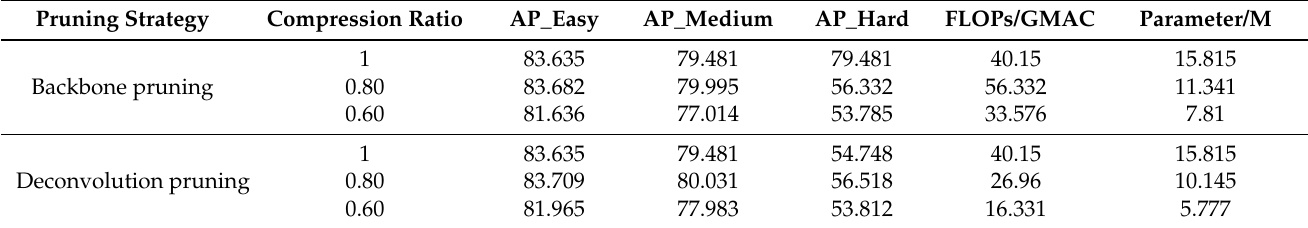
Table 2. Comparison of different approaches for CNN inference.